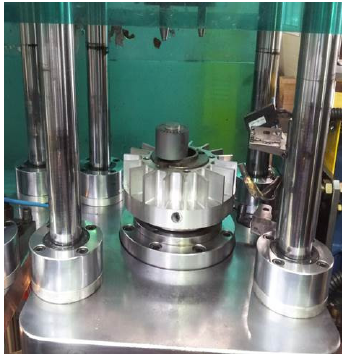
Figure 2. Centrifugal casting method.